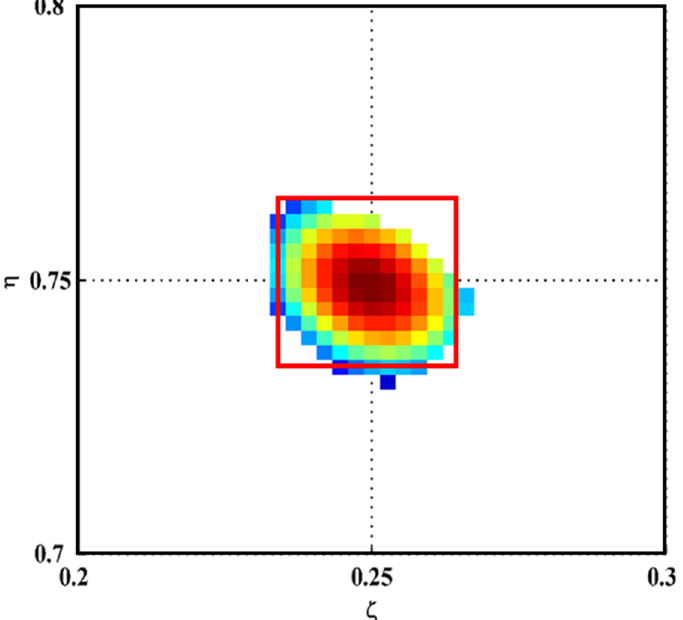
Figure 9. Zoomed-in planform of the FEMDI (outlines of the actual region of the delamination are marked in red).